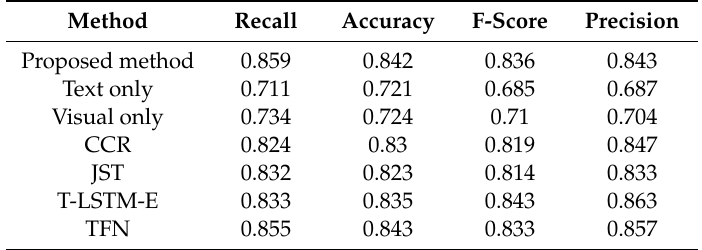
Table 3. Performance of various sentiment analysis methods on Twitter.